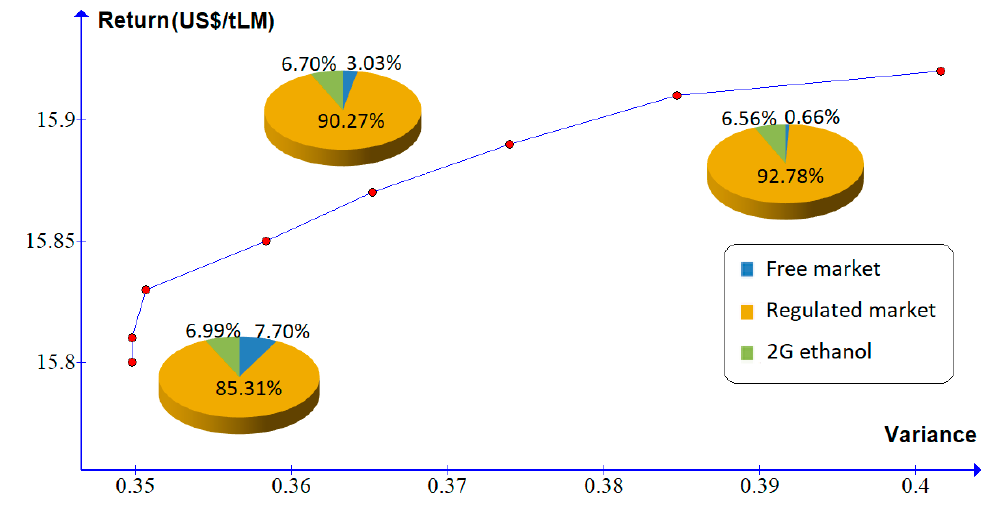
Figure 5. Efficient frontier for scenario 3.